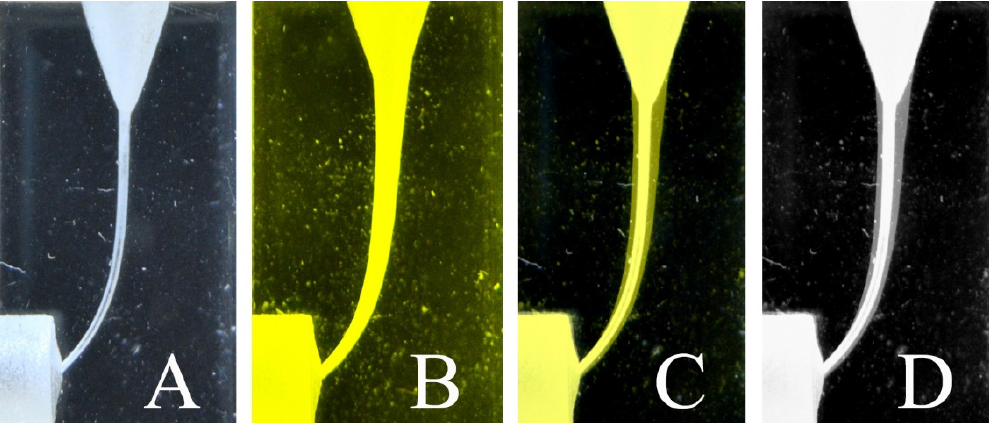
Figure 1. ( A ) preoperative image; ( B ) postoperative image with color-shifted image processing; ( C ) preoperative–postoperative composite image; and ( D ) grayscale image.